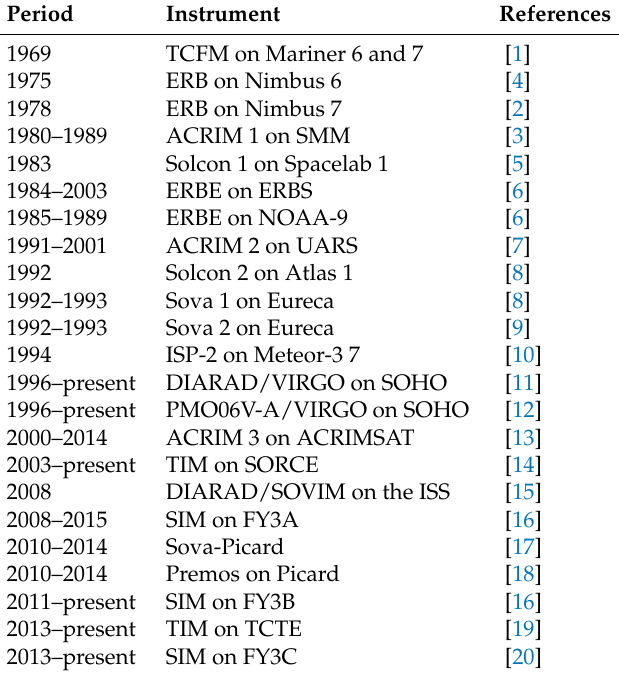
Table 1. Total Solar Irradiance space instruments. TCFM: Temperature Control Flux Monitor; ERB: Earth Radiation Budget; ACRIM: Active Cavity Radiomer Irradiance Monitor; SMM: Solar Maximum Mission; SOLCON: Solar Constant; ERBE: Earth Radiation Budget Experiment; ERBS: Earth Radiation Budget Satellite; NOAA: National Oceanic and Atmospheric Administration; UARS: Upper Atmosphere Research Satellite; ATLAS: Atmospheric Laboratory for Applications and Science; SOVA: Solar Variability; EURECA: European Retrievable Carrier; ISP: Solar Constant Gauge; DIARAD: Differential Absolute Radiometer; VIRGO: Variability of Irradiance and Gravity Oscillations; SOHO: Solar and Heliospheric Observatory; PMO: Physikalisches und Meteorologisches Observatorium; TIM: Total Irradiance Monitoring; SORCE: Solar Radiation and Climate Experiment; SOVIM: Solar Variability Irradiance Monitor; SIM: Solar Irradiance Monitor; FY: Feng Yung; PREMOS: Precision Monitor Sensor; TCTE: Total Solar Irradiance Calibration Transfer Experiment. Period